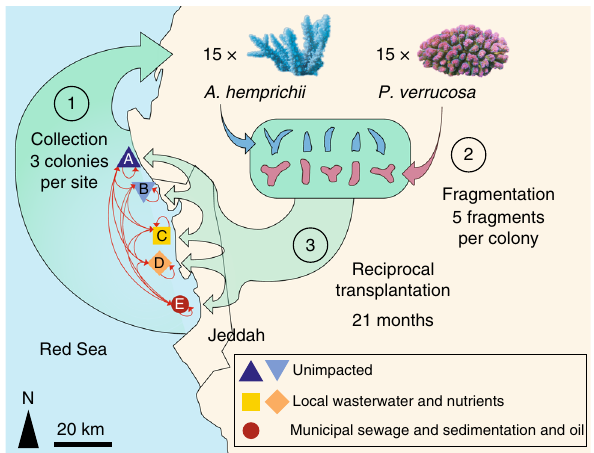
Fig. 1 Design of transplantation experiment. Back-transplantation and cross-transplantation of coral fragments from Acropora hemprichii and Pocillopora verrucosa across sites of differing environmental impact close to the Saudi Arabian city of Jeddah in the Red Sea to test for microbiome fl exibility. Three coral colonies of each species at each site were collected and fragmented into fi ve fragments each per colony to allow for reciprocal transplantation across all sites. GPS locations for site A: N 21°52 ′ 22.83 ″